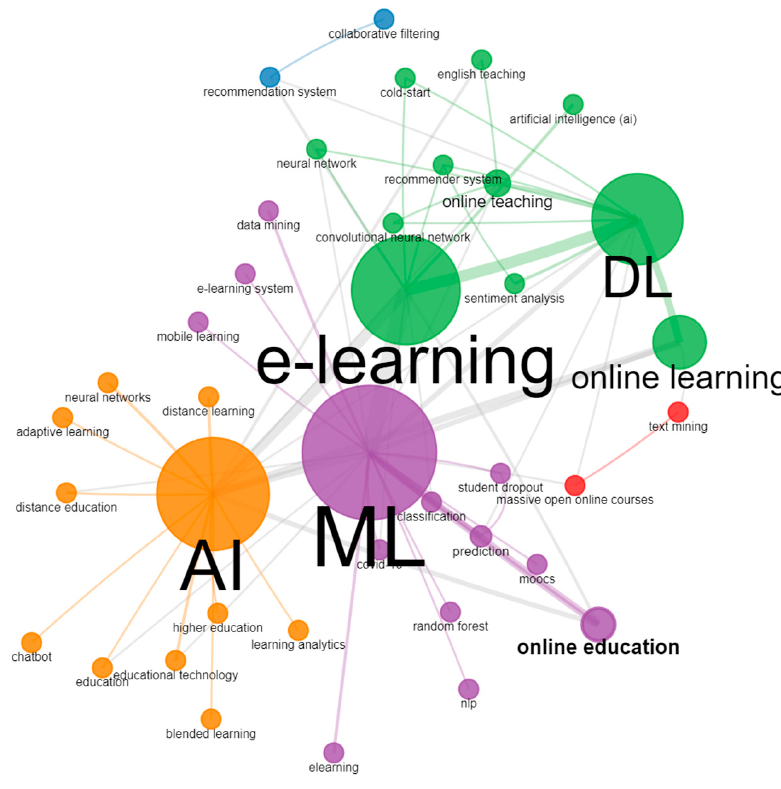
Figure 6. Social network analysis of the